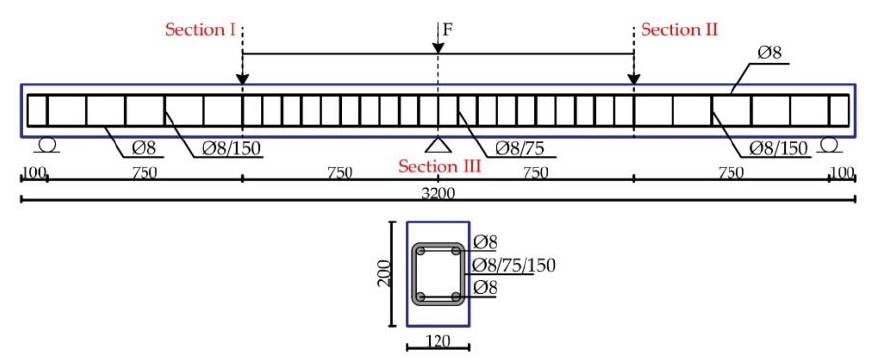
Figure 1. Reinforcing of the tested beams.